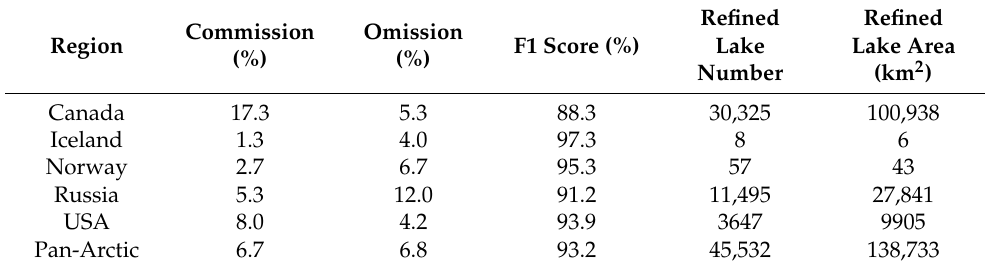
Table 1. Evaluation of the refined lake extent.